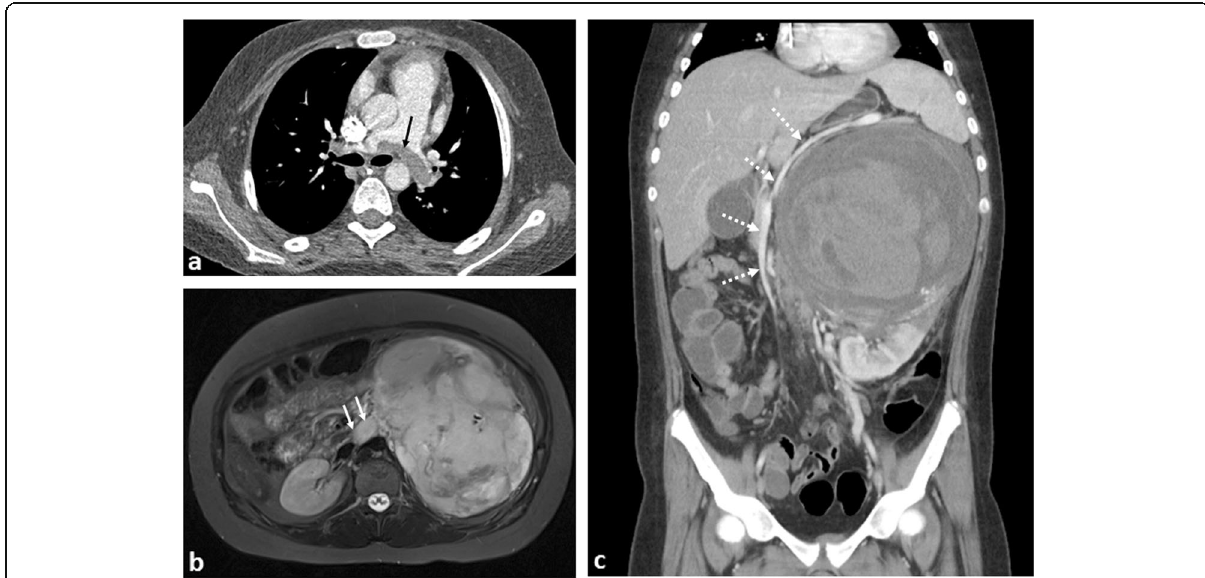
Fig. 18 A 13-year-old girl with left-sided Wilms ’ tumour and saddle pulmonary embolus. a Axial computed tomographic pulmonary angiogram (CTPA) demonstrates a saddle pulmonary embolus occupying the right and left pulmonary arteries (black arrow). b Axial T2-weighted fat- saturated MR image reveals a left renal mass with tumour thrombus occupying the entire left renal vein (white arrow). c Coronal contrast- enhanced CT image of the abdomen shows the heterogeneously enhancing left renal mass, with internal haemorrhage. There is right-sided displacement of the IVC with the splenic vein (dashed arrows) stretched and draped over the